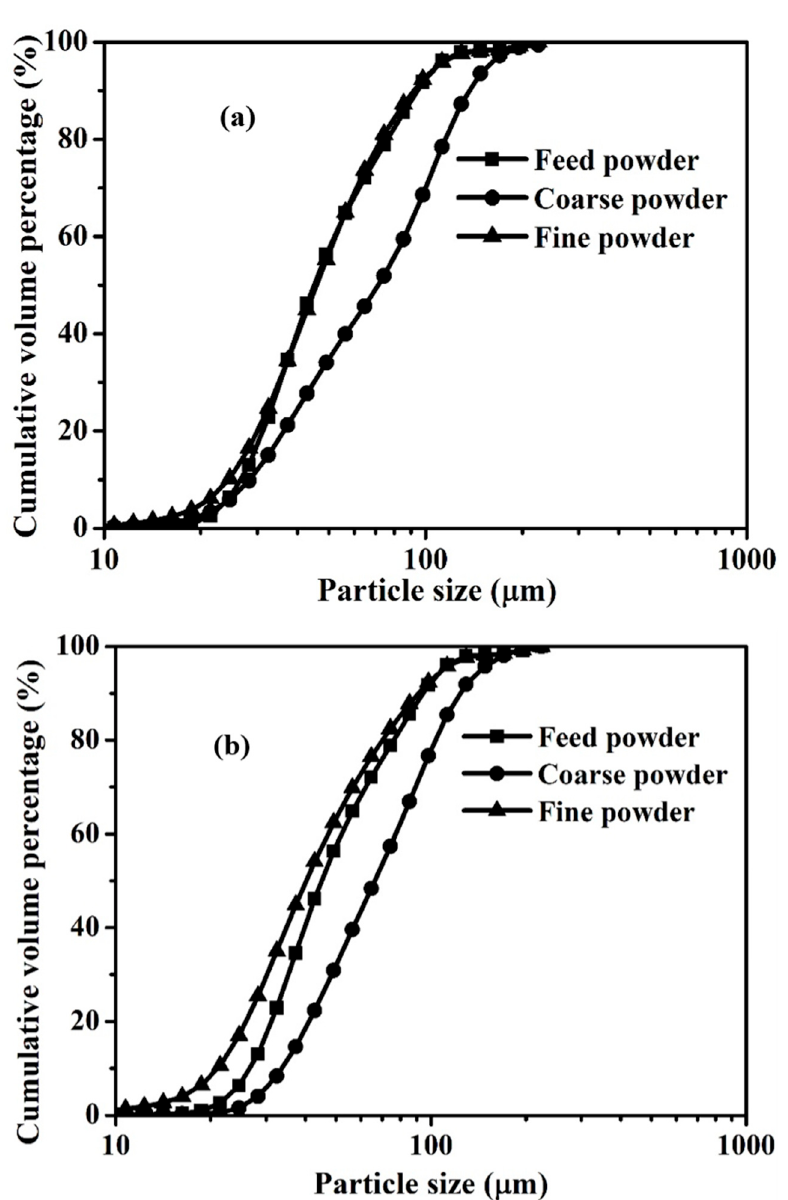
Figure 10. Particle size distributions of SAC305 powder from turbo air classifications performed using inlet air velocities of ( a ) 6.5 and ( b ) 8.5 m/s at the same rotor speed of 619 RPM and feed rate 4 kg/h.